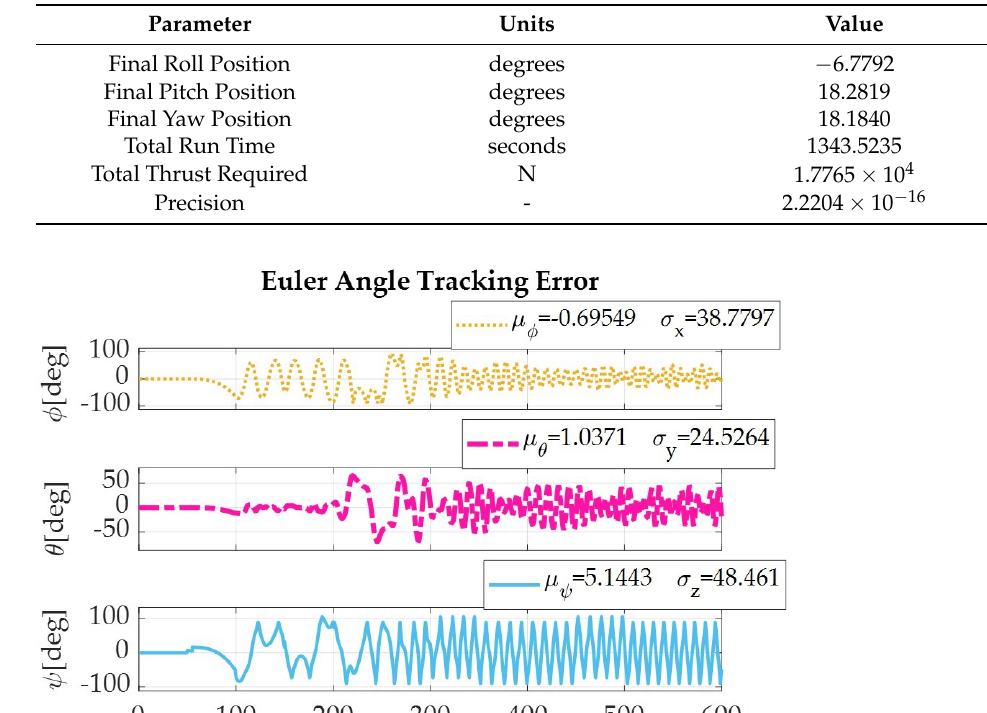
Table 5. Simulation results of the Pontryagin trajectory.